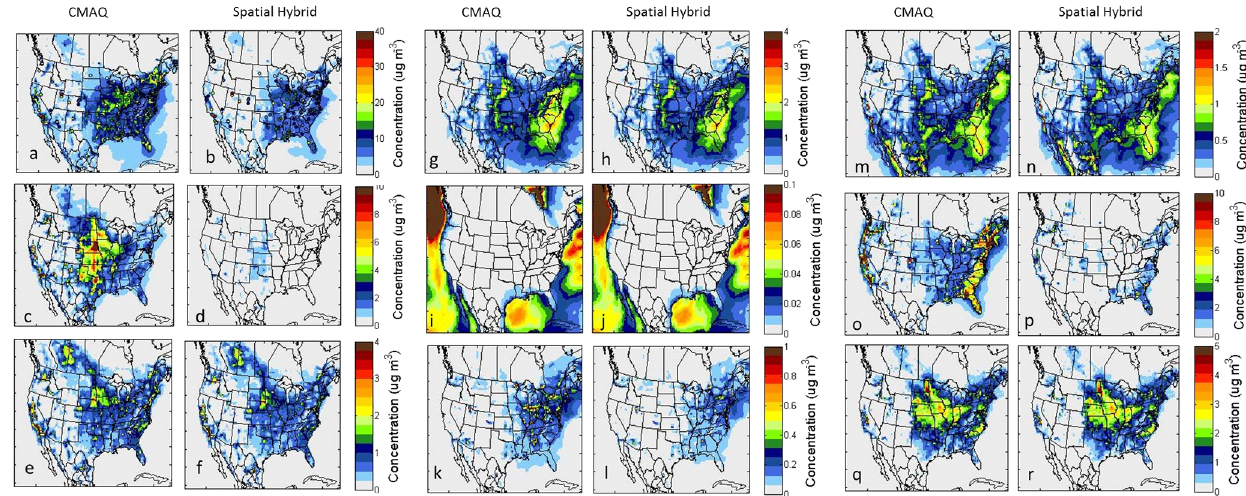
Figure 5. Average CMAQ–DDM and spatial hybrid source impacts on PM 2 . 5 for observation days in January 2004 for eight source cat- egories. Total PM 2 . 5 with overlapped PM 2 . 5 observations for 28 January (a, b) . Impact of (c, d) soil/crustal material, (e, f) traffic-related sources, (g, h) coal combustion, (i, j) sea salt aerosol, (k, l) metal-related sources, (m, n) fuel oil combustion, (o, p) biomass burning, and agricultural activities (q, r)